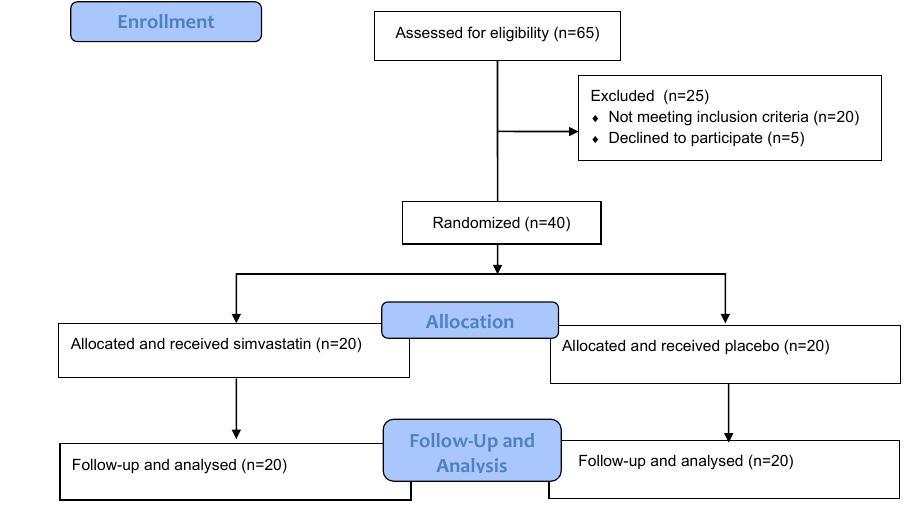
Figure 1. CONSORT flow diagram of the